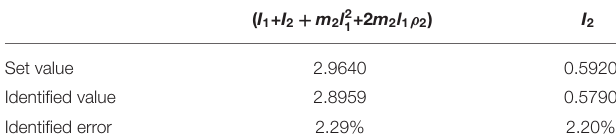
TABLE 2 | Identification result of the inertial parameters.